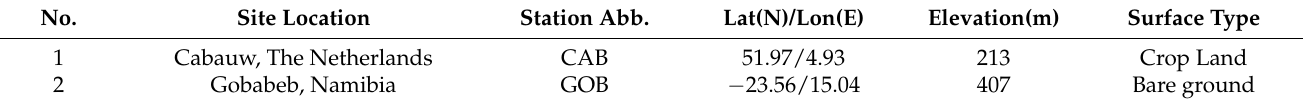
Table 2. Geo-Location and surface type of the two BSRN stations.